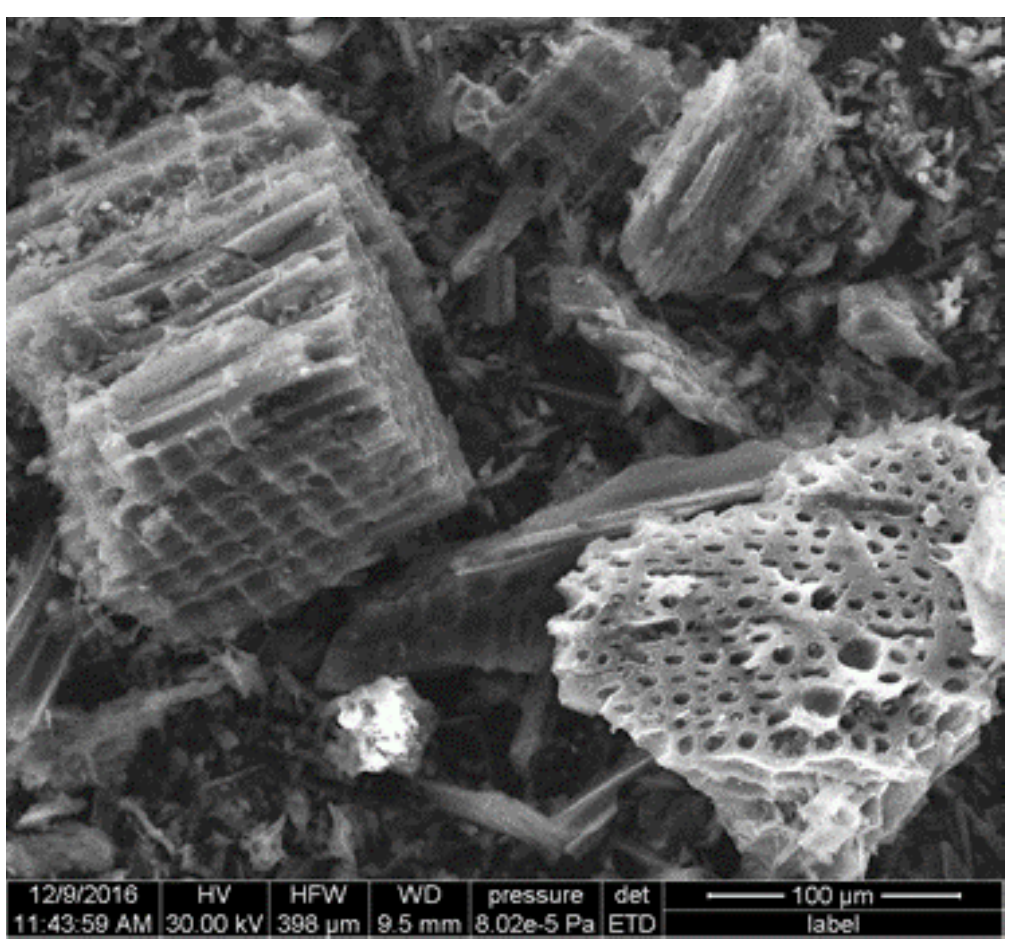
Figure 1. SEM of the powder-AC produced from beech wood.